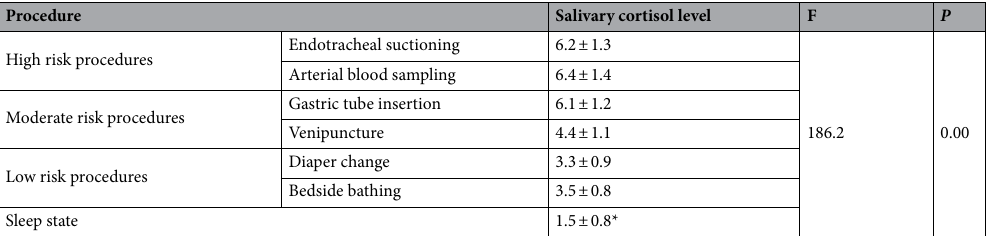
Table 1. Changes of saliva cortisol concentration in neonates with mechanical ventilation under different routine operations (nmol/L, x ± s). The collection time of each procedure: endotracheal suctioning (9:00, 21:00); Diaper changes (10:00, 04:00); Venipuncture (at admission); Bedside bathing (8:30); Gastric tube insertion (11:00); Arterial blood sampling (30 min after admission); Sleep state (once every night when sleeping).